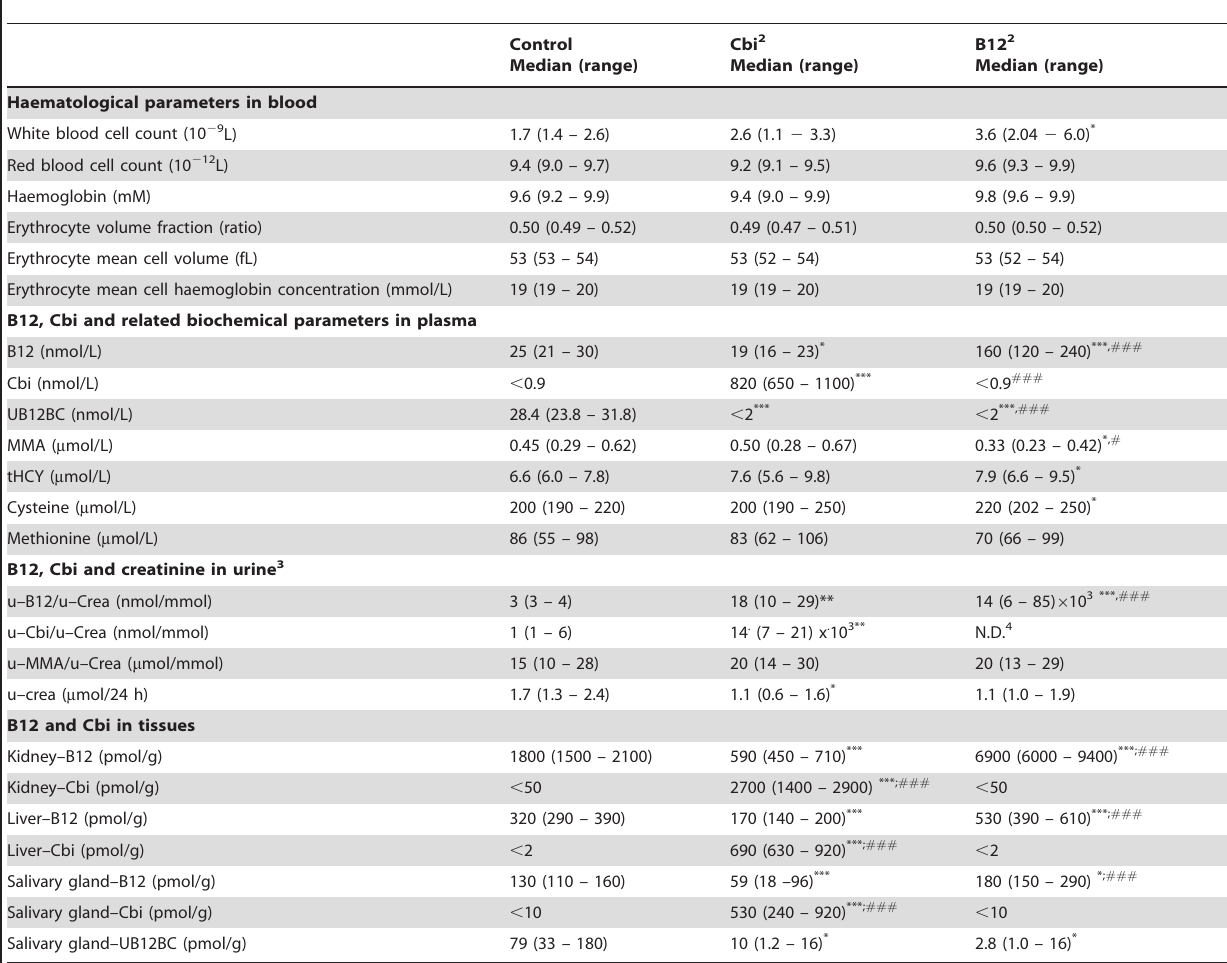
Table 2. B12-related parameters measure in mice following 27 days of continuous delivery of saline (control), cobinamide (Cbi) and vitamin B12 (B12) by osmotic minipumps 1